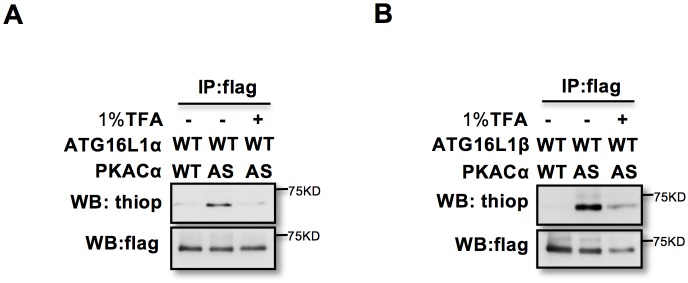
Thiophophorylation is converted to normal phosphoryation by 1% TFA acid–promoted hydrolysis.(A–B) ATG16L1α (A) and ATG16L1β (B) thiophosphorylated and immunoprecopitated as in Figure 1C, then treated with or without 1% TFA at 37°C for 4 hr.